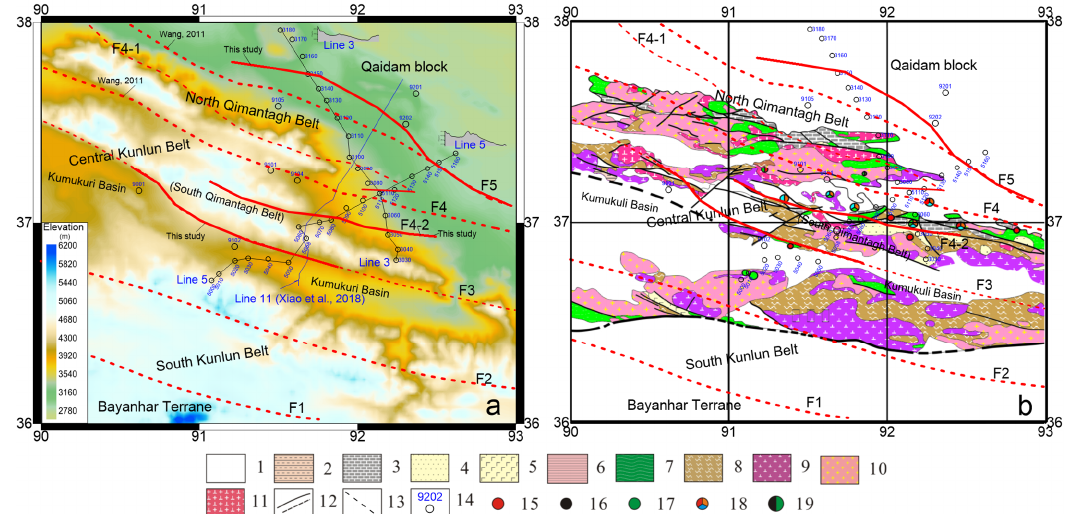
Figure 2. Regional topography and geological map of the Qimantagh Metallogenic Belt. ( a ) Regional topography and field layout of magnetotelluric (MT) stations; ( b ) regional geological map [30]. 1. Neogene sediments, 2. Triassic Elashan Formation, 3. Carboniferous Shiguaizi Formation, 4. Devonian Maoniushan Formation, 5. Silurian Yaziquan Formation, 6. Silurian Baiganhu Formation,